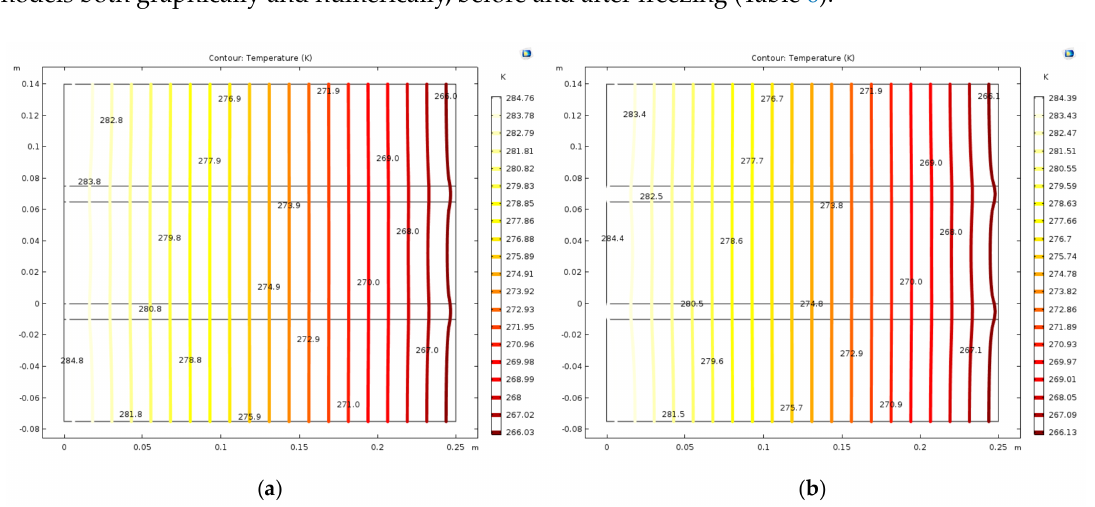
Figure 4. Isothermal contours in model 1: ( a ) Prior exposure to freeze / thaw cycles and ( b ) after exposure to freeze / thaw